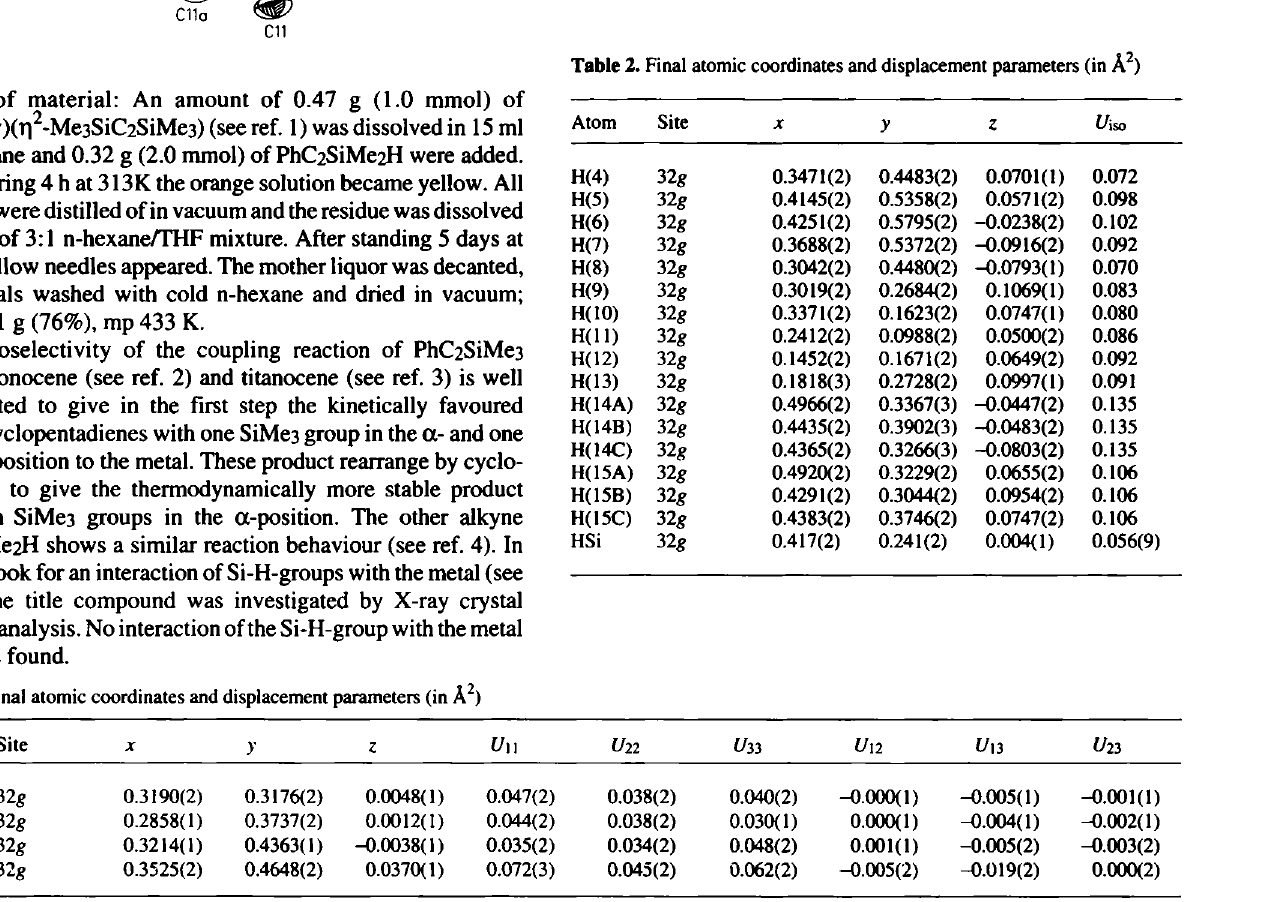
Table 1. Parameters used for the X-ray data collection Crystal: